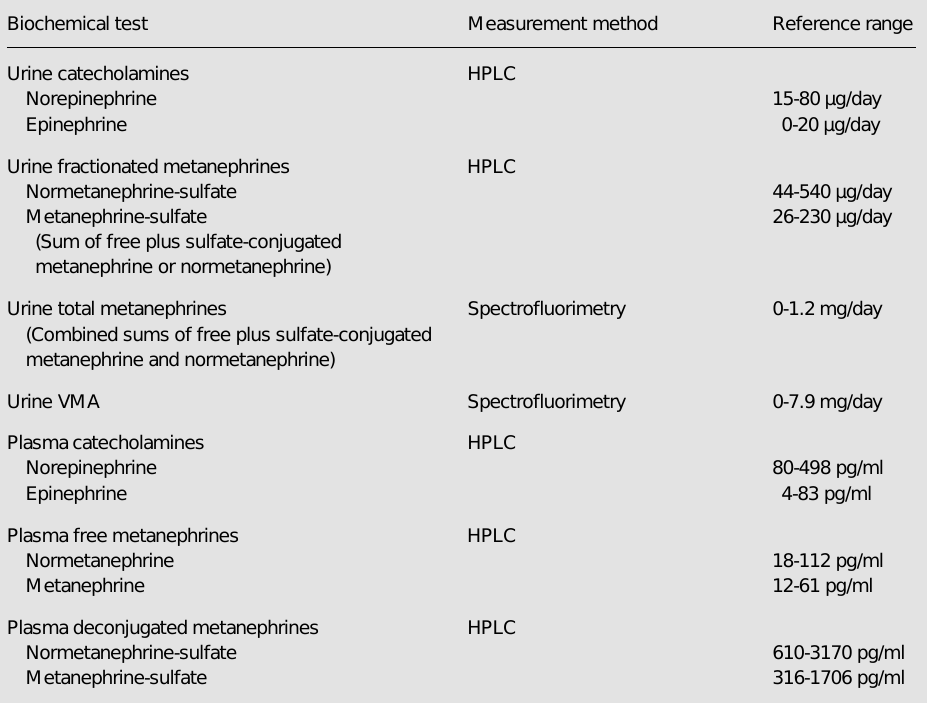
Table 1 - Biochemical tests for diagnosis of